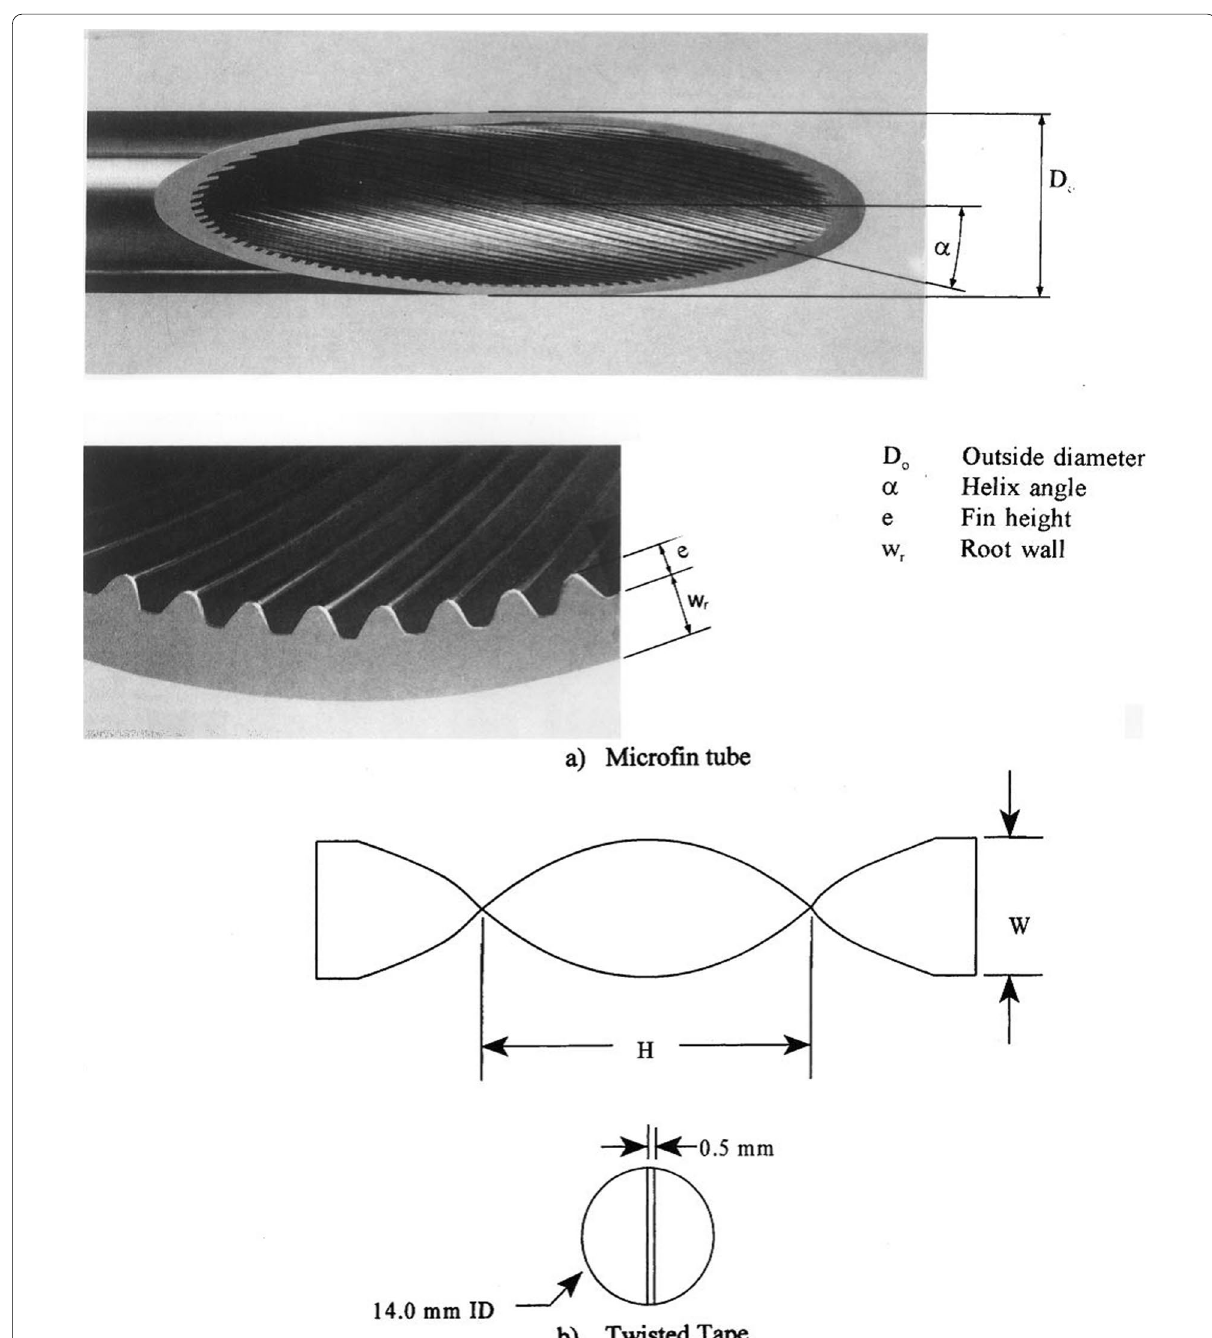
Fig. 6 Baffled Twisted Tape and hiTrain wire matrix with 14 mm outer diameter, 1.2–1.6 mm centre wire diameter, 190–210 loops per foot and length 825 mm [52]. a Microfin tube, b Twisted